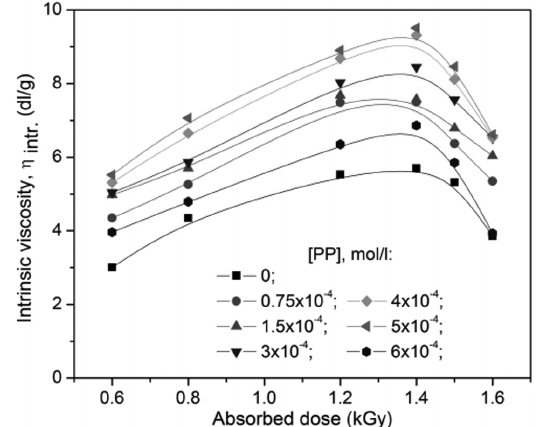
Figure 1. The effect of initiator concentration and EB absorbed dose on conversion coefficient (C